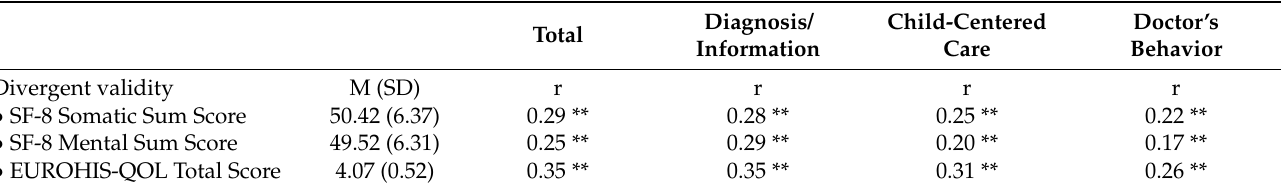
Table 5. Correlation coefficients between overall scale and sub-scale scores of the self-report version of the CHC-/YHC- SUN-SF ( n = 469) and generic satisfaction with health care (single CHC-/YHC-SUN single-item measure) as well as several quality of life indicators (SF-8, EUROHIS-QOL; n = 469).